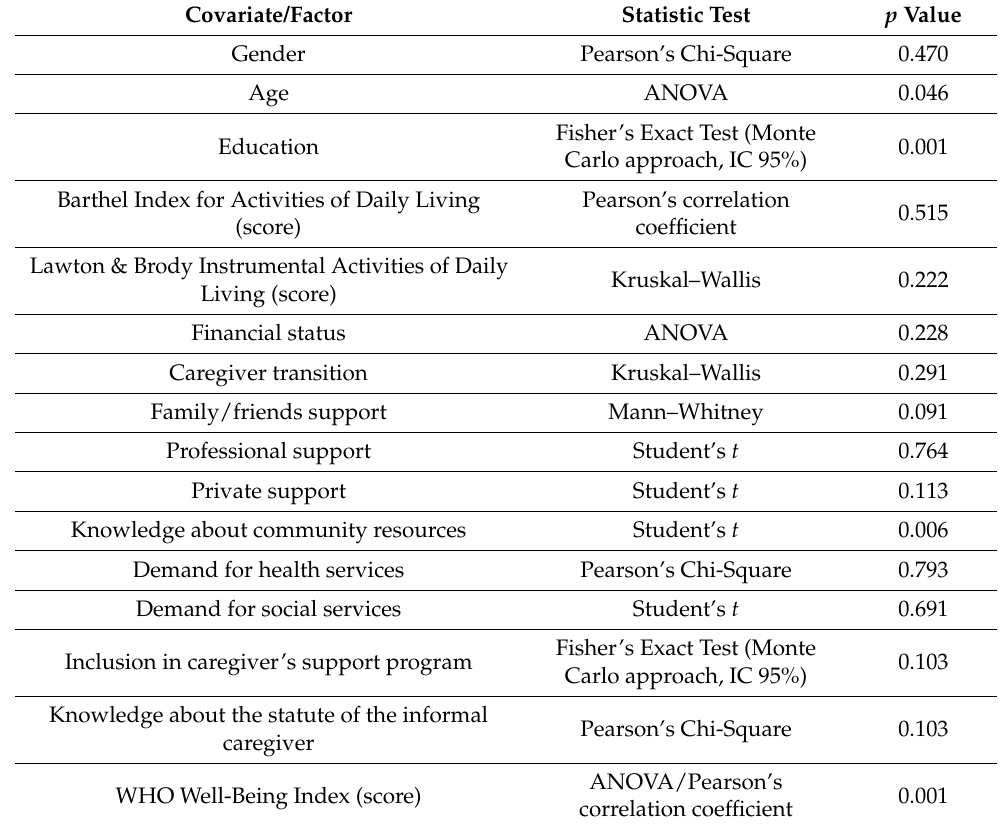
Table 4. Bivariate statistics—health literacy and sociodemographic factors (short version).